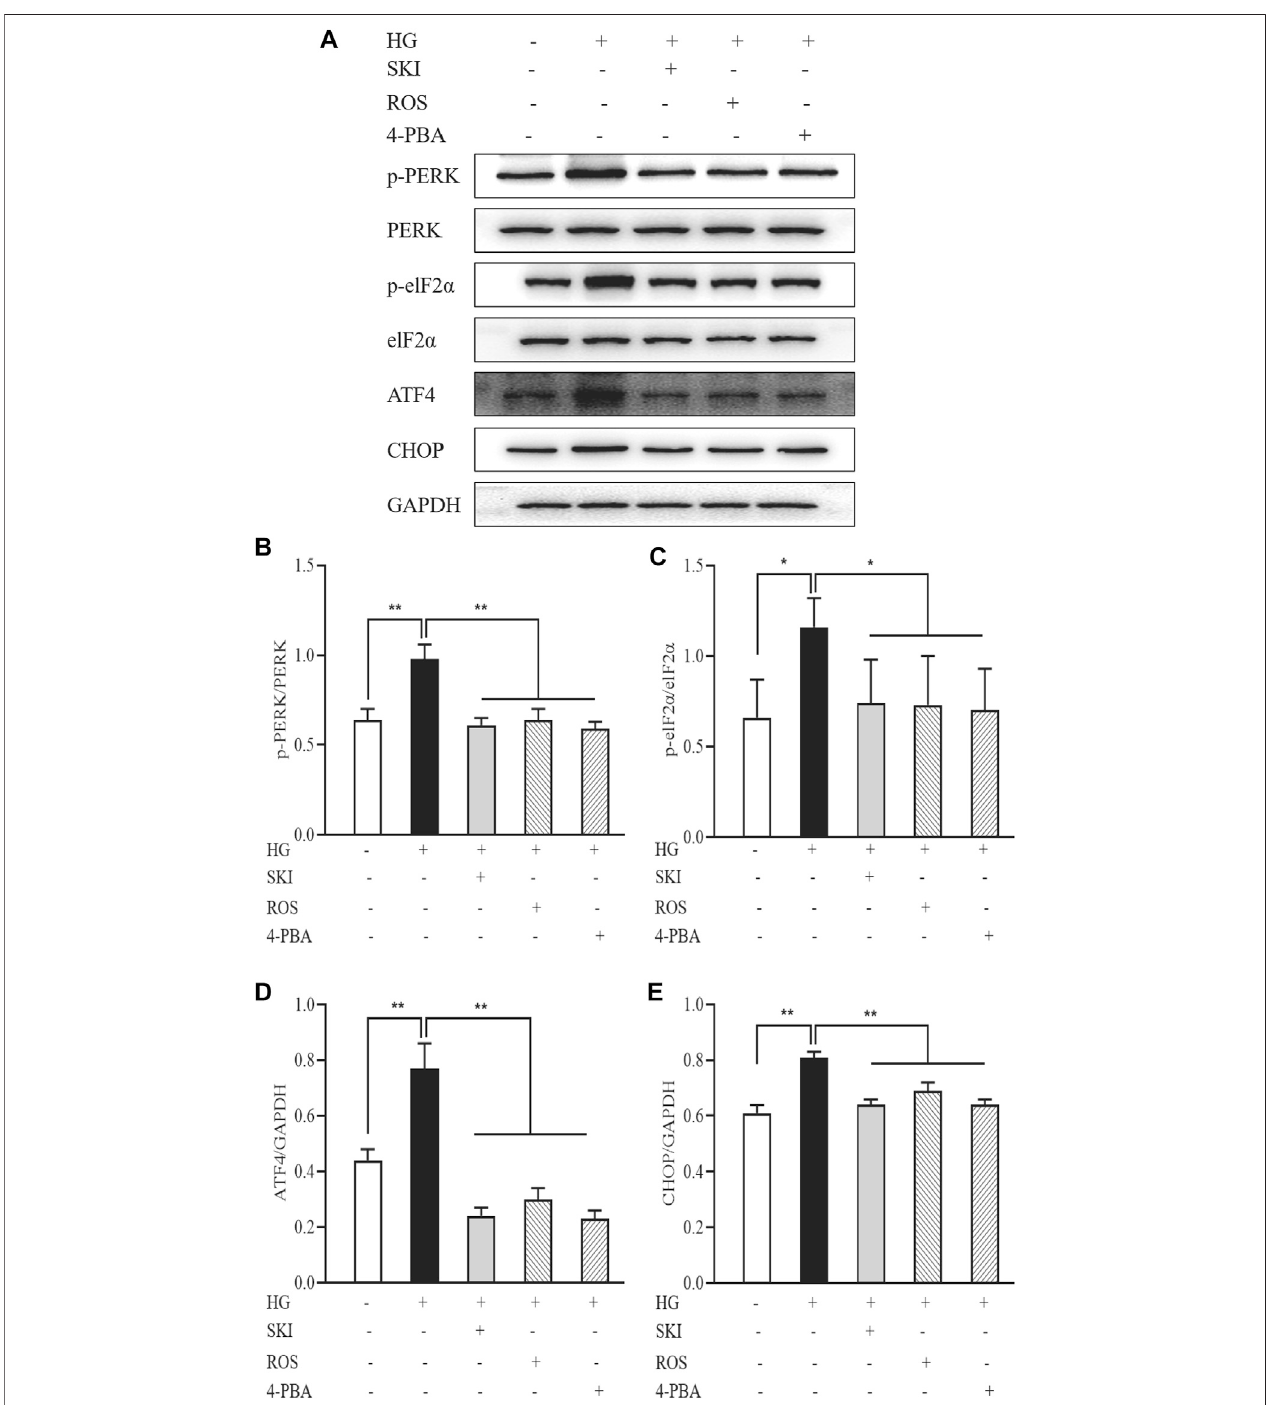
FIGURE 13 | The effects of SKI and ROS on the expression levels of key signaling molecules in the PERK-eIF2 α -ATF4-CHOP pathway in vitro . (A) WB analysis of p-PERK, PERK, p-eIF2 α , eIF2 α , ATF4, and CHOP, in NRK-52E cells exposed to HG and 4-PBA with or without SKI or ROS for 24 h (B – E) The rate of p-PERK to PERK and p-eIF2 α to eIF2 α , and the rate of ATF4 and CHOP toGAPDH, respectively. Dataare expressed asmean ± S.E. * p < 0.05, ** p < 0.01. Abbreviations: PERK, double- stranded RNA (PKR)-activated protein kinase-like eukaryotic translation initiation factor 2 α (eIF2 α ) kinase; eIF2 α , double-stranded RNA (PKR)-activated protein kinase-like eukaryotic translation initiation factor 2 α ; ATF4, activating transcription factor 4; CHOP, C/EBP homologous protein; WB, Western blot; GAPDH, glyceraldehyde-3-phosphate dehydrogenase; HG, high glucose; 4-PBA, 4-phenylbutyric acid; ROS, rosiglitazone; SKI, Shenkang injection.